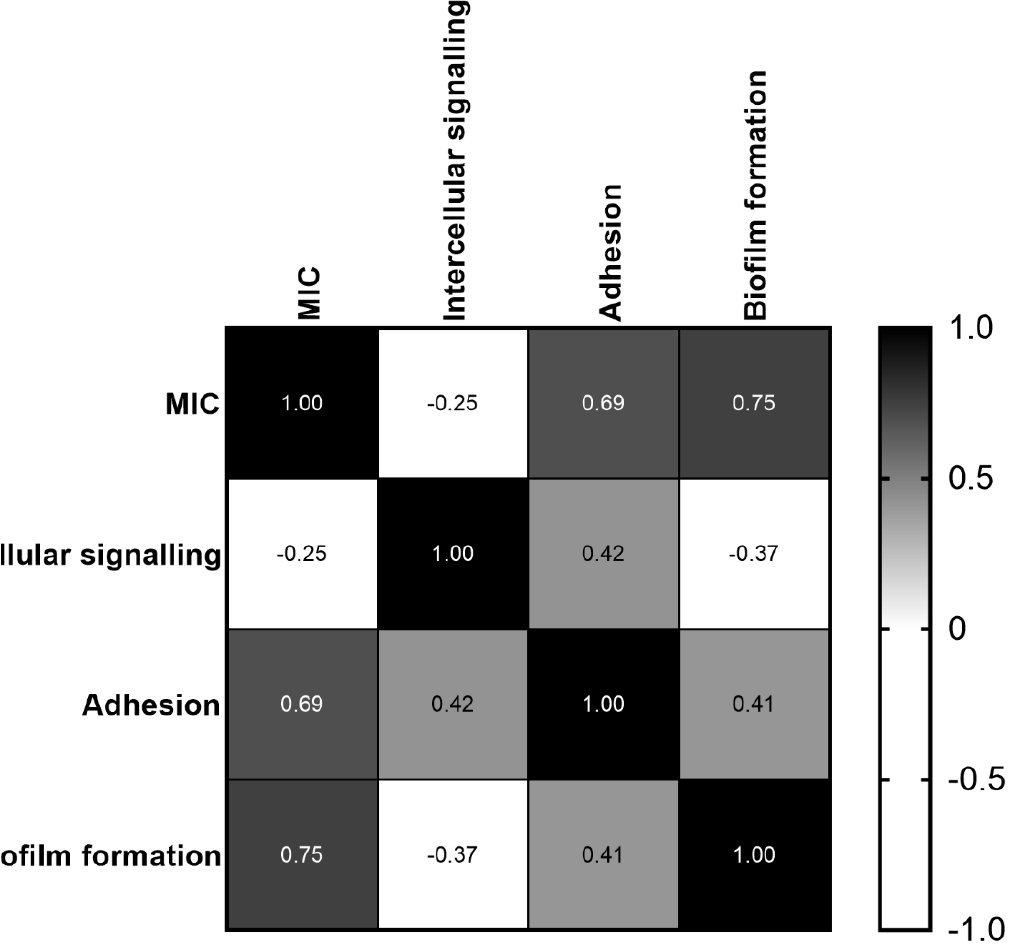
Figure 4. Correlation between MIC of lavandin formulations, C. jejuni intercellular signaling, adhesion and biofilm formation. Pearson’s correlation test was used in order to determine the correlation among variables. For the Pearson correlation, an absolute value of 1 indicates a perfect linear relationship. A correlation close to 0 indicates no linear relationship between the variables. The sign of the coefficient indicates the direction of the relationship. Correlation was significant at the level < 0.01.